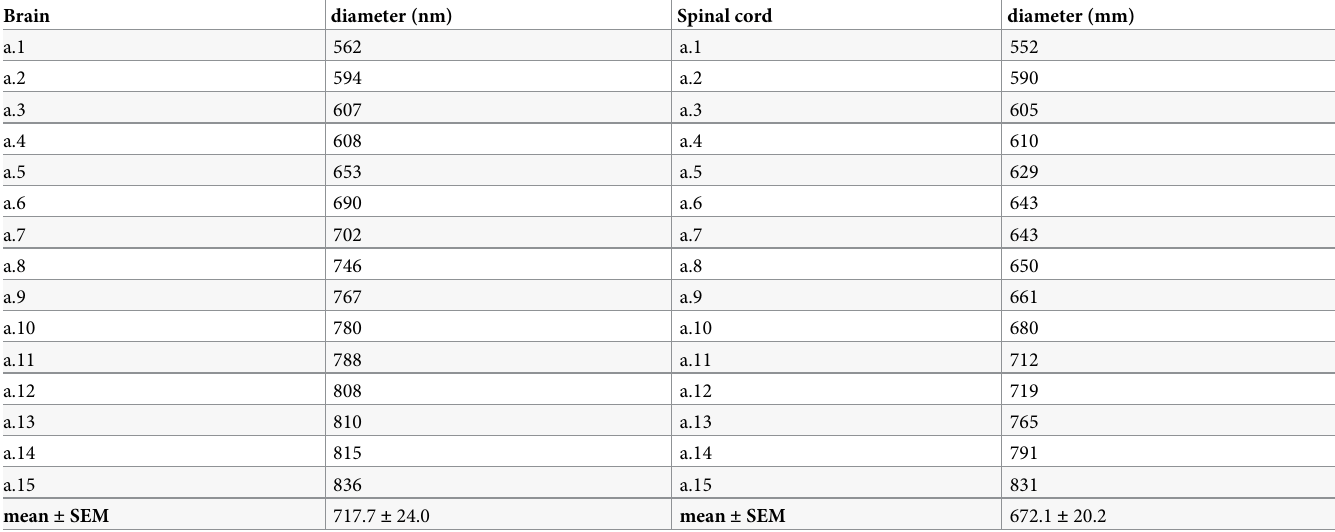
Table 2. Measures of mean diameter of the axons in brain and spinal cord.